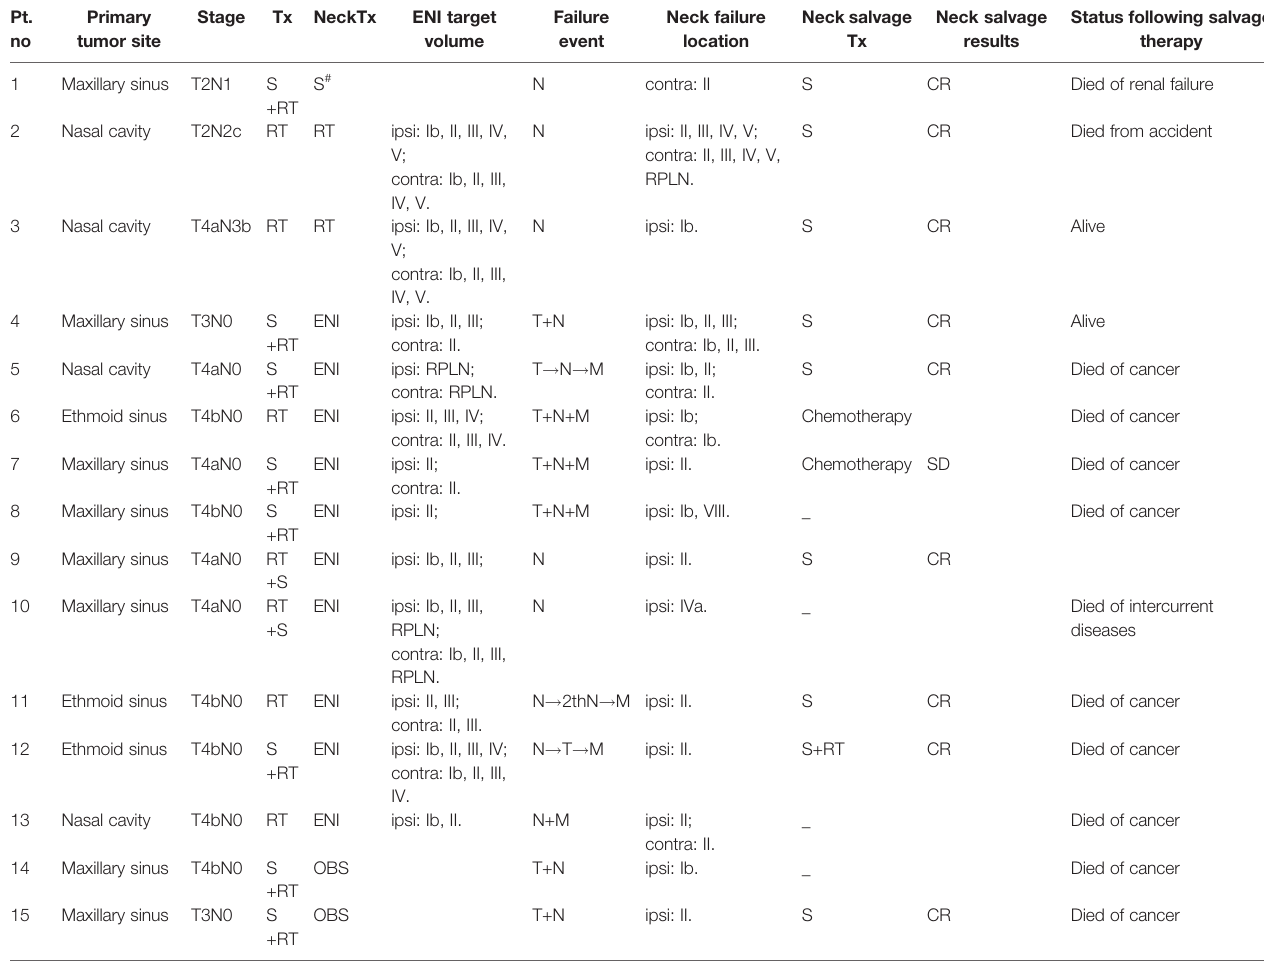
TABLE 4 | Details of 19 patients with regional